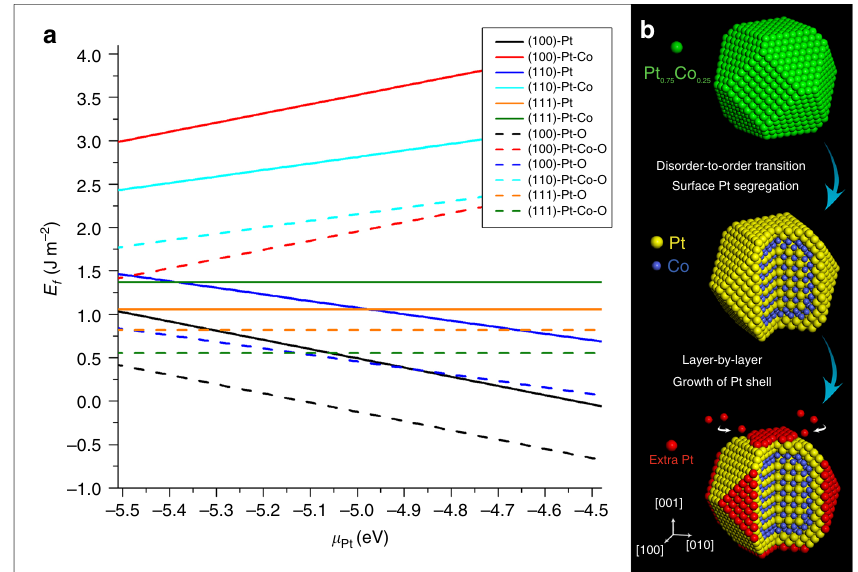
Fig. 4 Structure evolution during oxygen-induced core-shell formation. a DFT calculation results of the formation energy on several possible surfaces of the ordered intermetallic Pt 3 Co phase. b Schematic diagrams showing the process of the oxygen-driven core-shell formation in Pt 3 Co